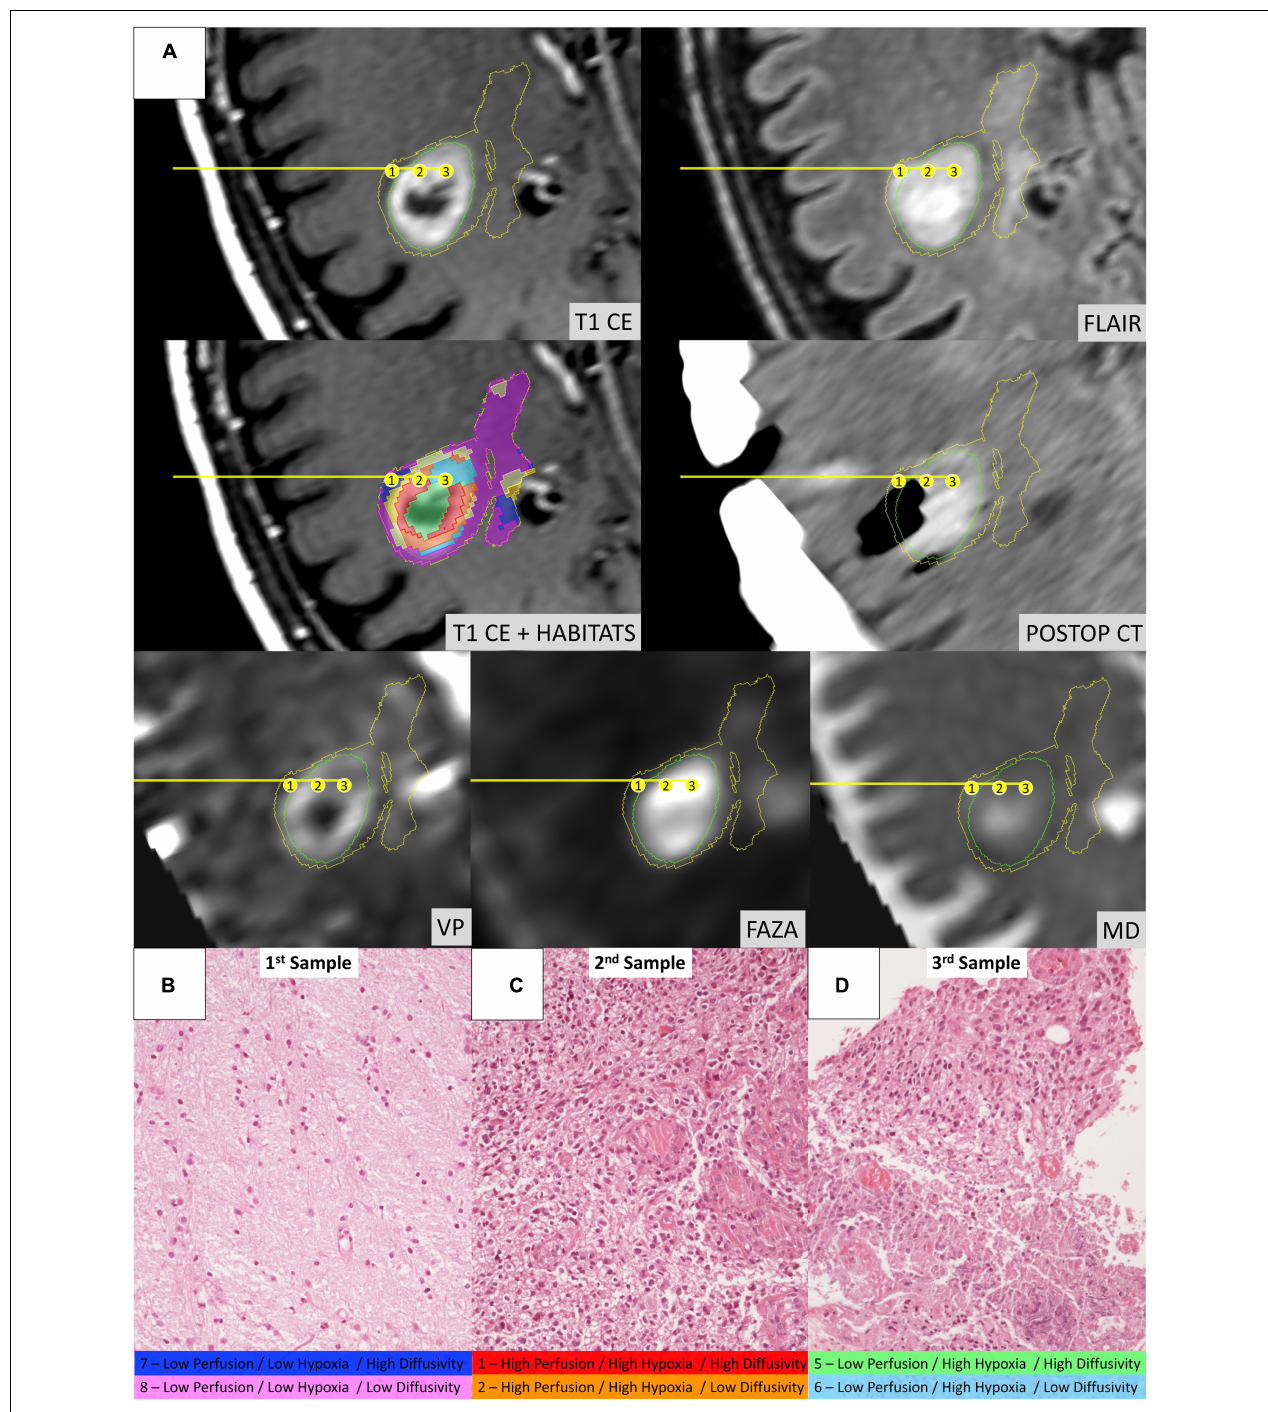
FIGURE 6 | Illustrative case of a 58-year-old male patient (Case 2 in Table 1 ) who underwent stereotactic biopsy. (A) The trajectory path (yellow line) and the three consecutive sampling sites (enumerated in the yellow circles) are displayed in axial formatted pre-operative T1-CE, FLAIR, MD, 18 F-FAZA, Vp, and post-operative CT images; habitats were identified using the same key-color described in Figure 5 . (B) Microscopic slide [20 × magnification, Hematoxylin and Eosin (H&E)] from the first sampling (Habitat 7–Low Perfusion/Low Hypoxia/High Diffusivity and Habitat 8–Low Perfusion/Low Hypoxia/Low Diffusivity) showing a seemingly normal white matter architecture. (C) Microscopic slide (20 × magnification, H&E) from the second sampling (Habitat 1–High Perfusion/High Hypoxia/High Diffusivity and Habitat 2–High Perfusion/High Hypoxia/Low Diffusivity) showing evident hypercellularity with nuclear atypias and marked vascular proliferation. (D) Microscopic slide (20 × magnification, H&E) from the third sampling (Habitat 5–Low Perfusion/High Hypoxia/High Diffusivity and Habitat 6–Low Perfusion/High Hypoxia/Low Diffusivity) areas of vital tumoral tissue (on the upper part) mixed with areas of necrosis (on the lower part).